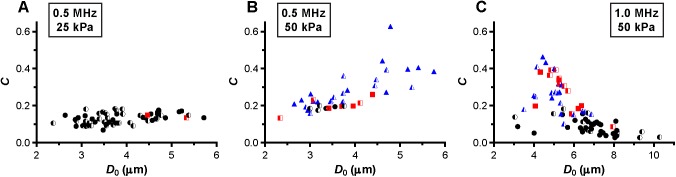
Relative compression amplitude, C.For microbubbles insonified at a frequency of 0.5 MHz and P_ of 25 kPa (A), frequency of 0.5 MHz and P_ of 50 kPa (B), and frequency of 1 MHz and P_ of 50 kPa (C). For figure legend, see the rightmost column of Fig 2 and Fig 3.